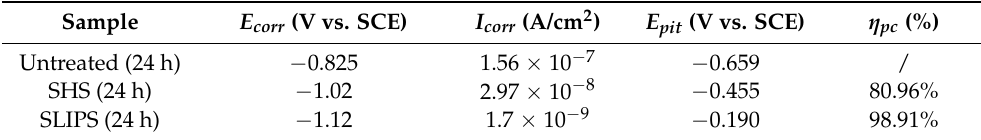
Table 3. The characteristic parameters obtained from Polarization curves after immersion in simulated seawater for 24 h.